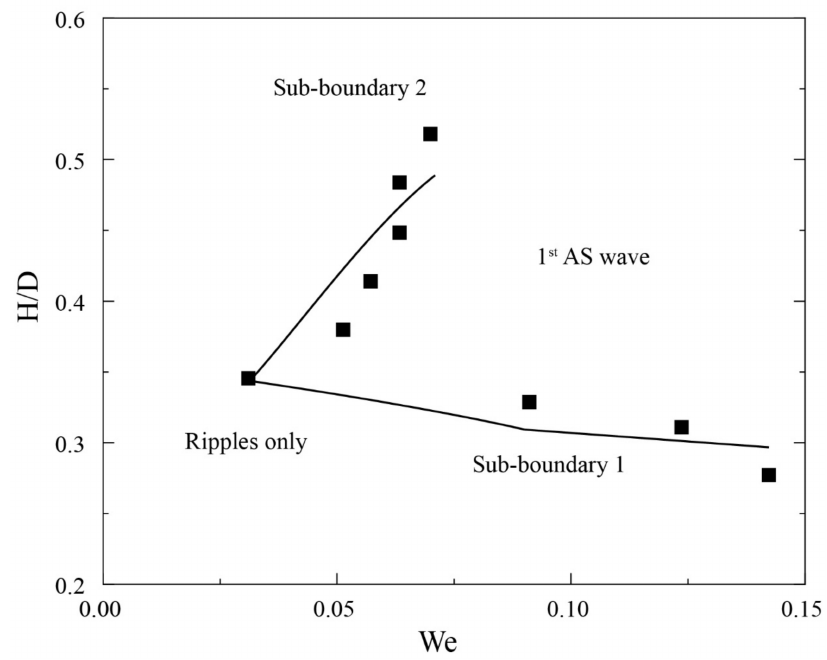
Figure 11. Occurrence condition of the 1st asymmetric standing wave at lance angle 7 ◦ , symbols are experimental points. Reprinted with permission from ref. [53]. Copyright 2021 Springer